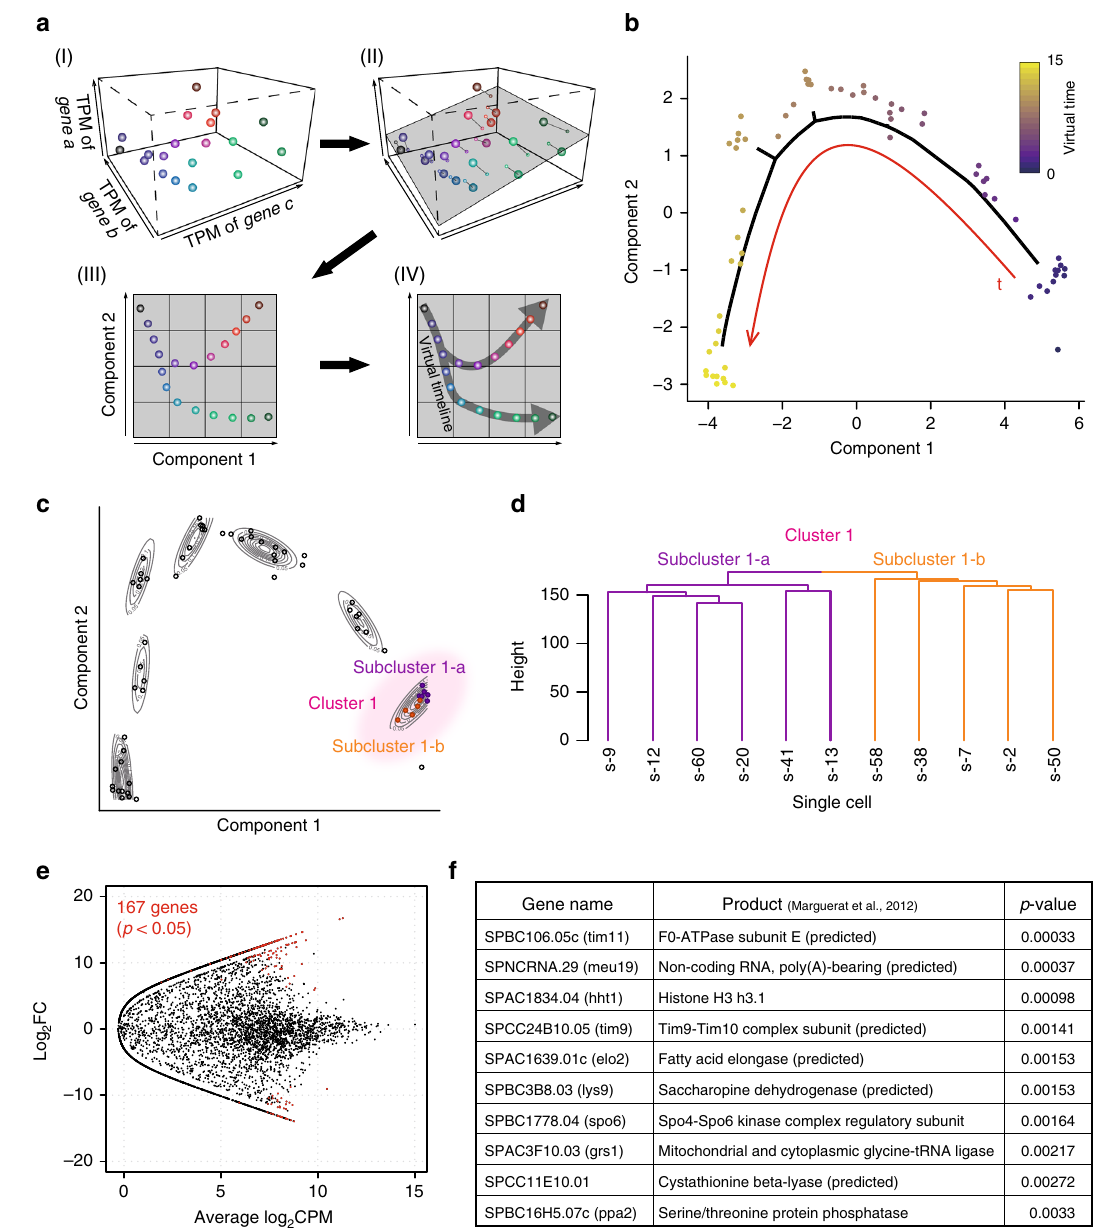
Fig. 3 Transcriptomes could be aligned along a virtual timeline. Bioinformatics approaches were applied to estimate temporal changes in gene expression pro fi les during germination. a Schematics illustrating the idea of the monocle-based similarity judgement. (I) Assuming that a cell contains three genes (a – c). In this example, transcriptomes can be plotted in three-dimensional space (dots in the graph) depending on the extent to which these genes were expressed. (II) Those data points can be projected onto a single plane (grey) so that the number of dimensions can be reduced from 3 to 2, as depicted in (III). In the two-dimensional plane, the Euclidean distance between data points indicates the similarity between two transcriptomes, and this similarity is used to estimate the time fl ow of the virtual timeline through a minimum spanning tree (IV). b Two-dimensional transcriptome plots, which were compressed from ~7000 dimensions using repetitive monocle operations. We used 64 samples created from single spores before and after nutrition feeding (0, 1 and 3 h). The red curve indicates the virtual timeline, and transcriptomes were aligned in the time course indicated by the heat map. c Plots in b were classi fi ed into seven clusters along the virtual timeline. Cluster 1 (pink) corresponds to the very initial stage of germination estimated from the timeline, and plots therein could be further divided into two subclusters (1-a, purple; and 1-b, orange). d Transcriptomes in two subclusters were divided into distinct groups through an informatic operation. e The expression of ~7000 annotated genes (dots) was compared between subclusters 1-a and 1-b. An exact test (two-sided, p < 0.05) revealed 167 genes for which expression varied signi fi cantly between these subclusters (shown in red). f The top 10 genes with the highest p values among the 167 variable genes. Gene products were inferred from Marguerat et al 9 . Source data are provided as a Source Data fi